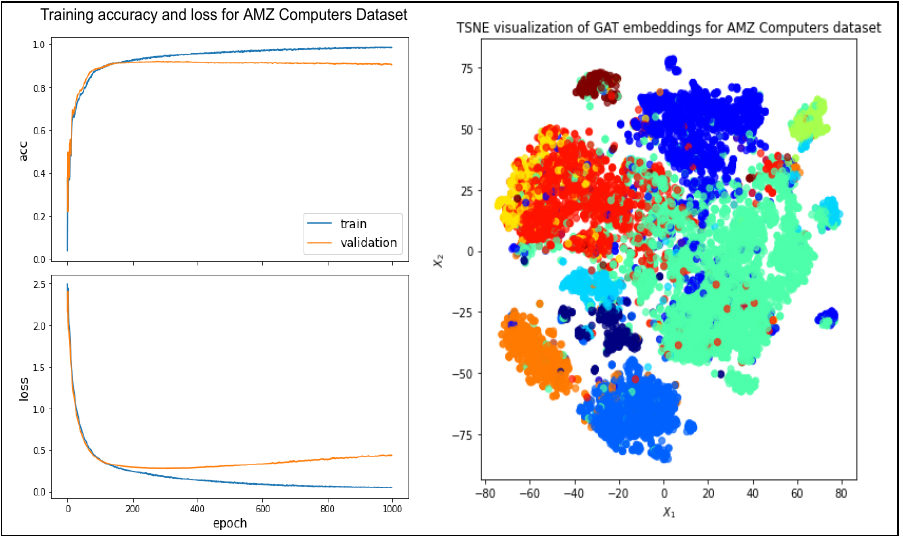
Figure 11. Graphical representation for AMZ Computers dataset.